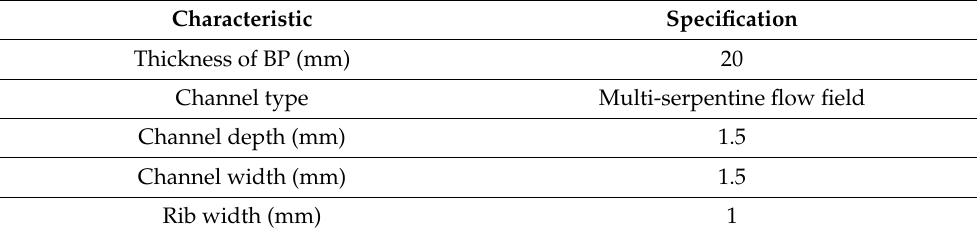
Figure 10. Serpentine nonparallel runner plate1. Table 1. Specification of the bipolar runner plate.